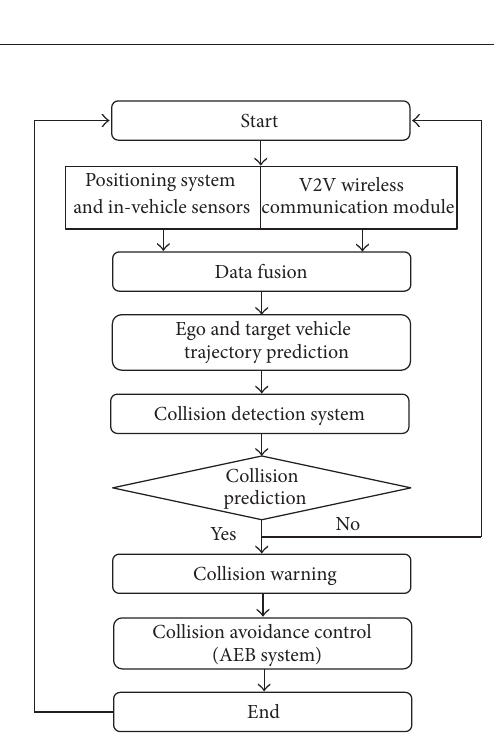
Figure 8: Flowchart of V2V communication-based AEB system.